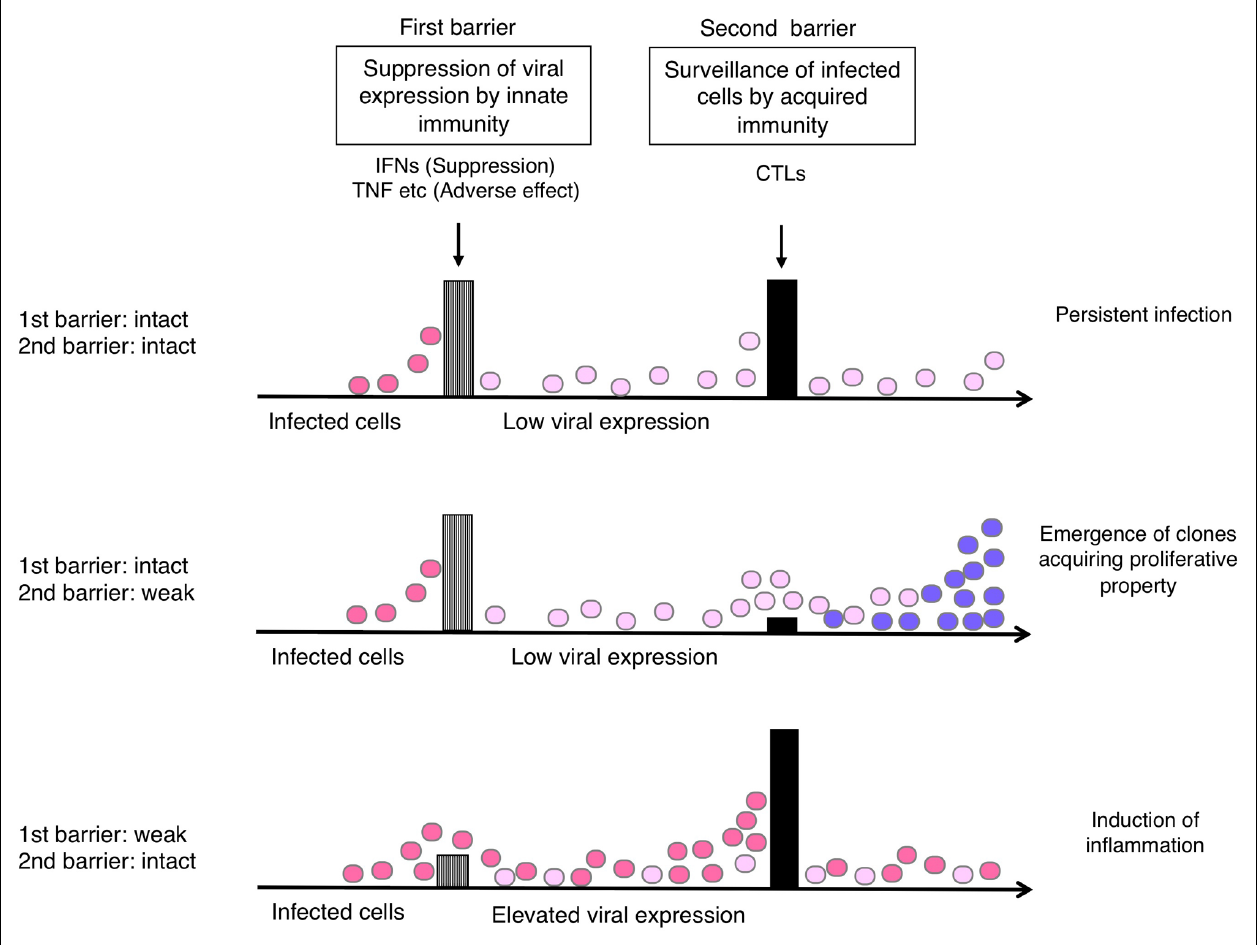
T-cell defense is insufficient (barrier 2: weak), the emergence of such clones may occur earlier. If the viral expression is not well controlled (barrier 1: weak), virus-induced inflammation may become apparent, but it also activates HTLV-1-specificT-cells that limit further growth of infected